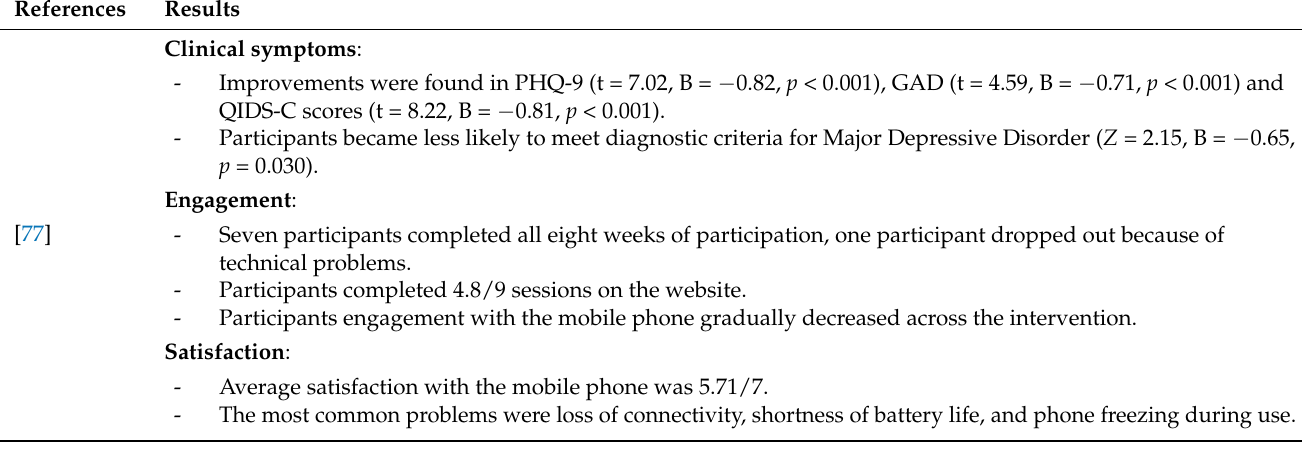
Table 2. Results of clinical symptoms, engagement, and